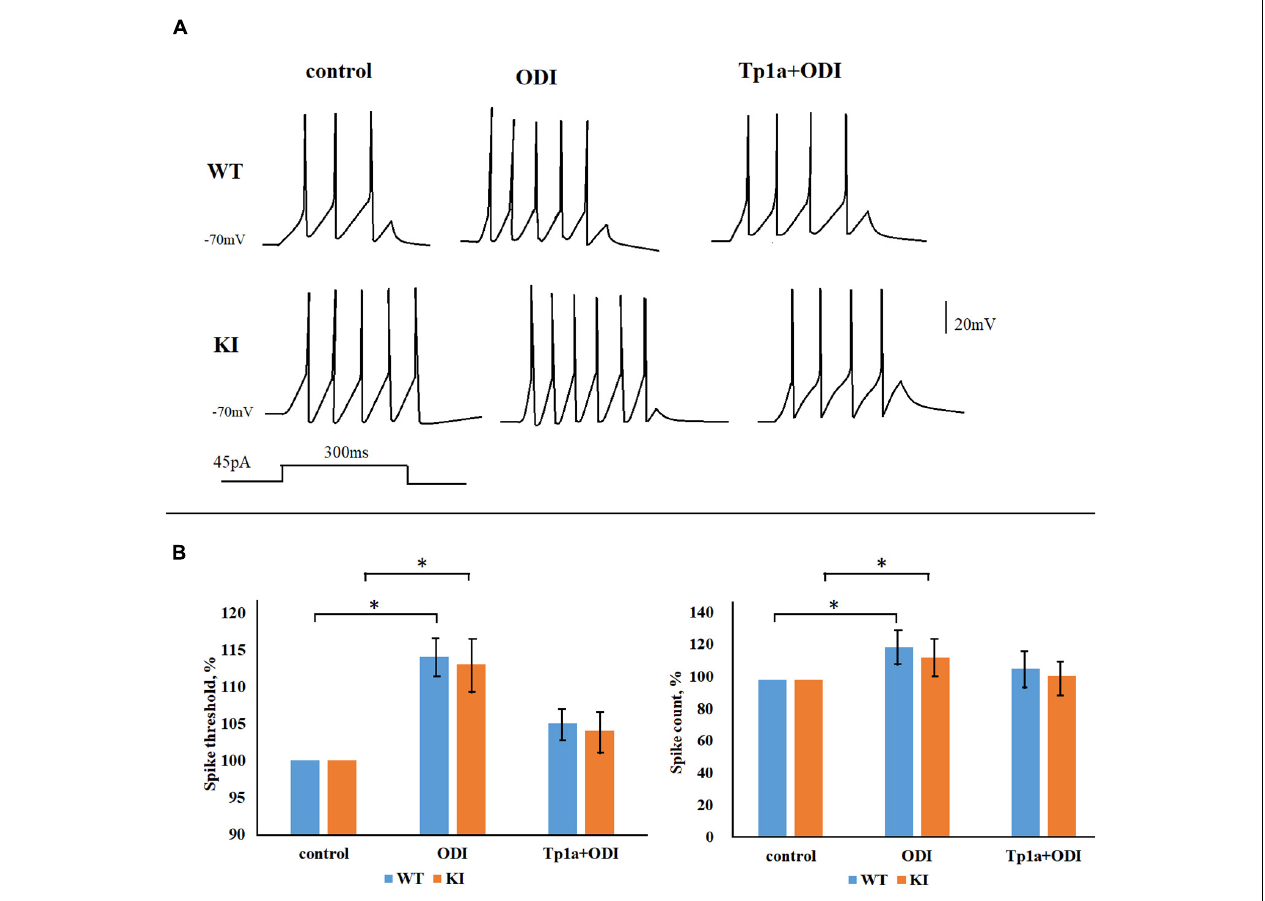
FIGURE 7 | OD1 elevates firing of TG neurons in response to a 45-pA 300-ms square current pulse. (A) Representative traces obtained from WT and R192Q KI TG neurons in control and after application of 10 nM OD1 (paired data, recordings from the same cell) or after application of 10 nM OD1 on cells pretreated with Tp1a (7 nM, 30 min; recordings from different cells). (B) OD1 application makes the AP threshold more negative and increases spike count both in WT and KI neurons (paired data); *Indicates statistically significant change (Mann-Whitney test, p -values are given in the text body). Number of cells in each group: n = 37 (WT, control), n = 36 (WT, OD1), i = 28 (KI, control), n = 25 (KI, OD1). The effect of OD1 is decreased when cells were pretreated with Tp1a (7 nM, 30 min); *Indicates statistically significant change (Mann–Whitney test, p -values are given in the text